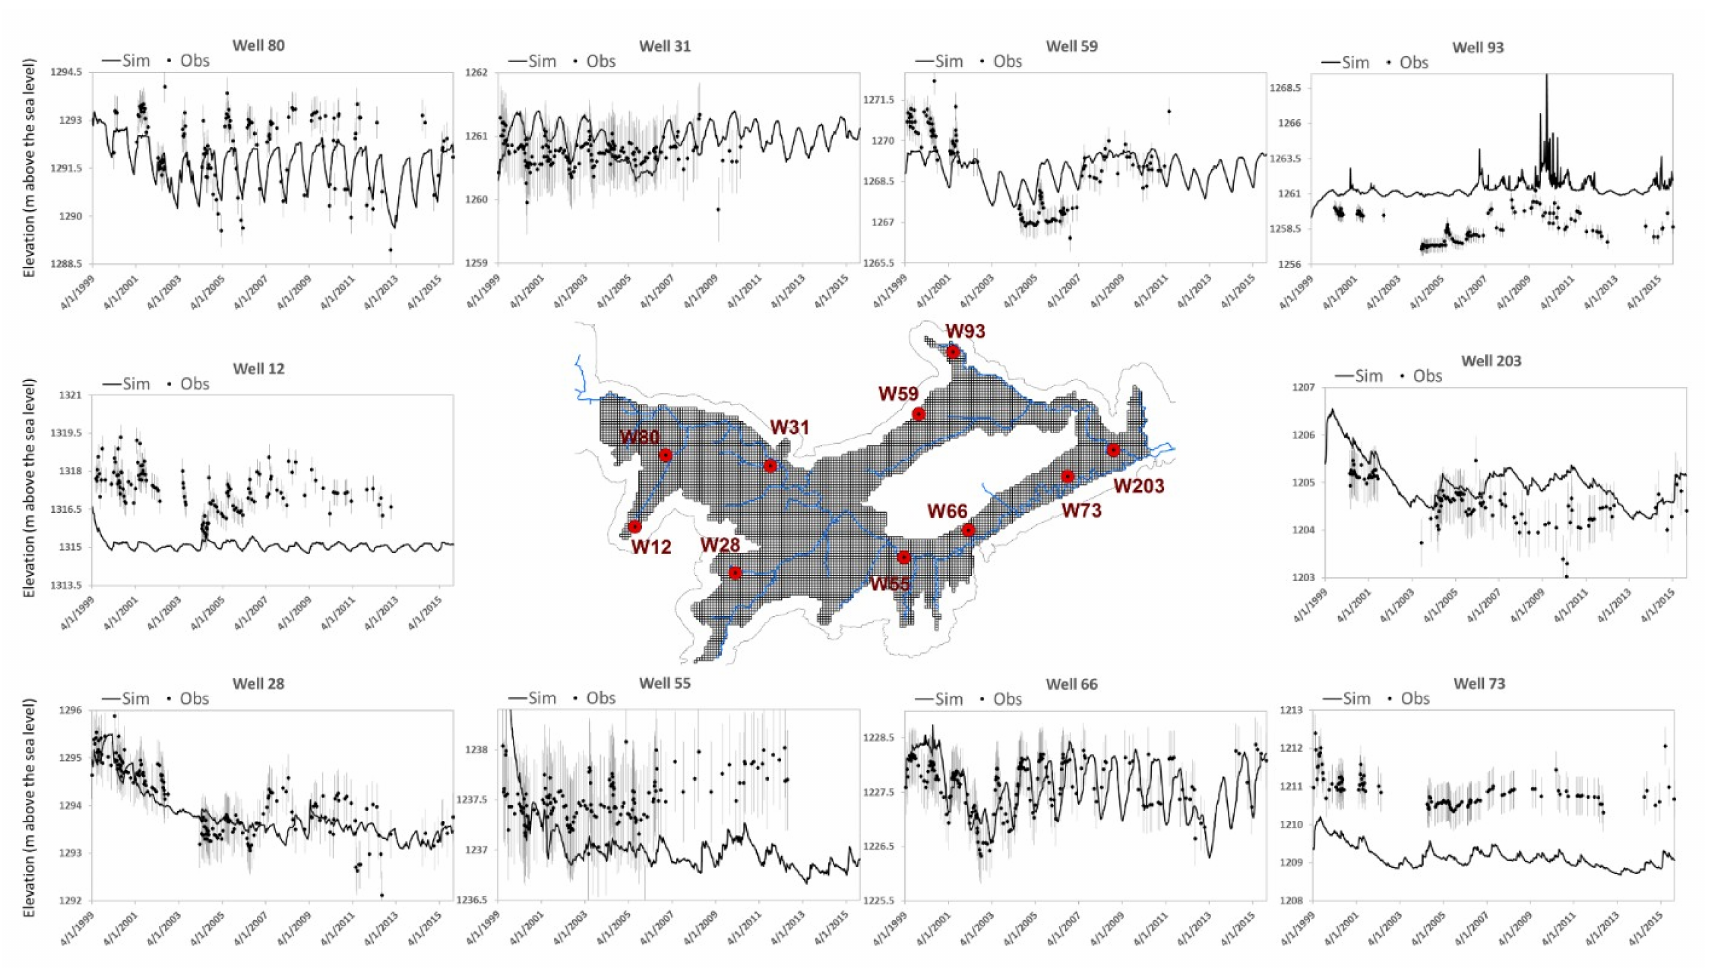
Figure 10. Spatial and temporal groundwater elevation distribution in cells containing monitoring wells at 10 locations over the 1999–2016 time period. Grey bars shown on observations indicate a 0.5-m